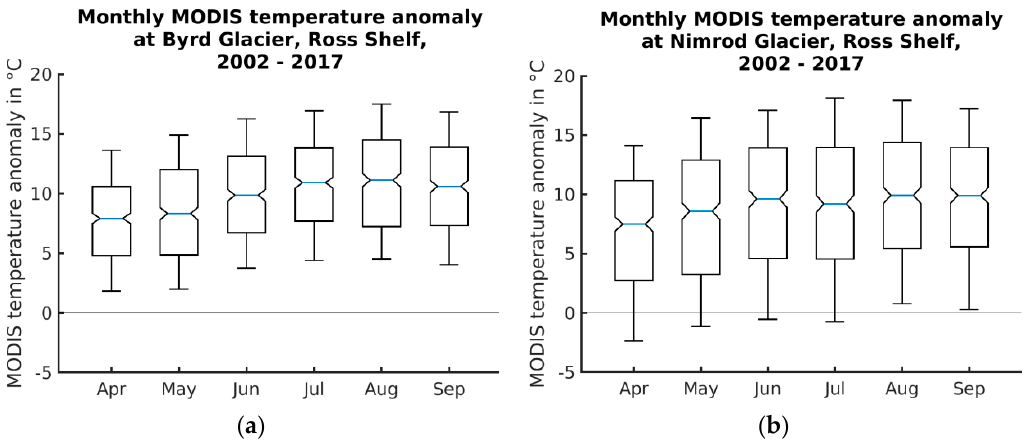
Figure 8. Box-whisker plot for the surface temperature anomaly for different months for winter (April–September) 2002 to 2017 for Byrd Glacier ( a ) and Nimrod Glacier ( b ). The median, the 25 and 75% percentiles are plotted as the box, the 10 and 90% percentiles are plotted as error bars.